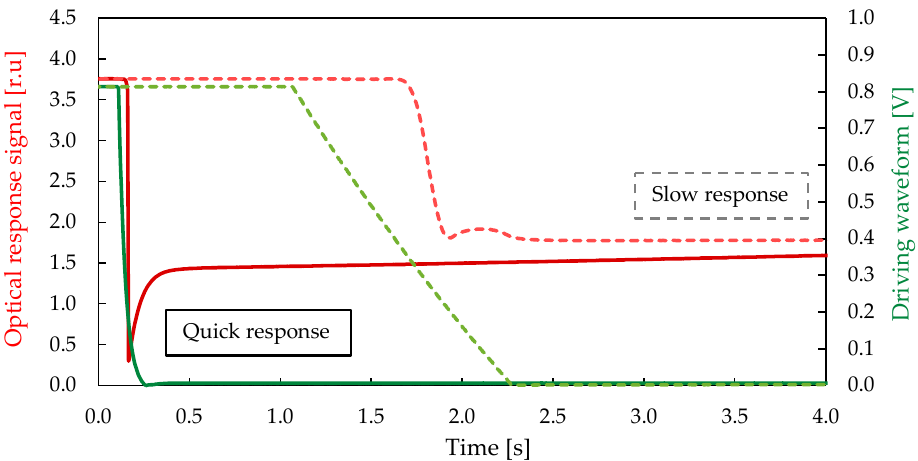
Figure 11. Electro-optical response of diffuser, discharged slowly through a resistor added in parallel. Note that changing resistor value from 1 k Ω to 0.970 k Ω decreases scattering state significantly. The shortest switching time for a PFLC is achieved by discharging through short- circuiting but then the transient peak is observed. If the discharge is slower, leading to longer switching times, the intensity of the transient peak decreases as well, see Figure 12.